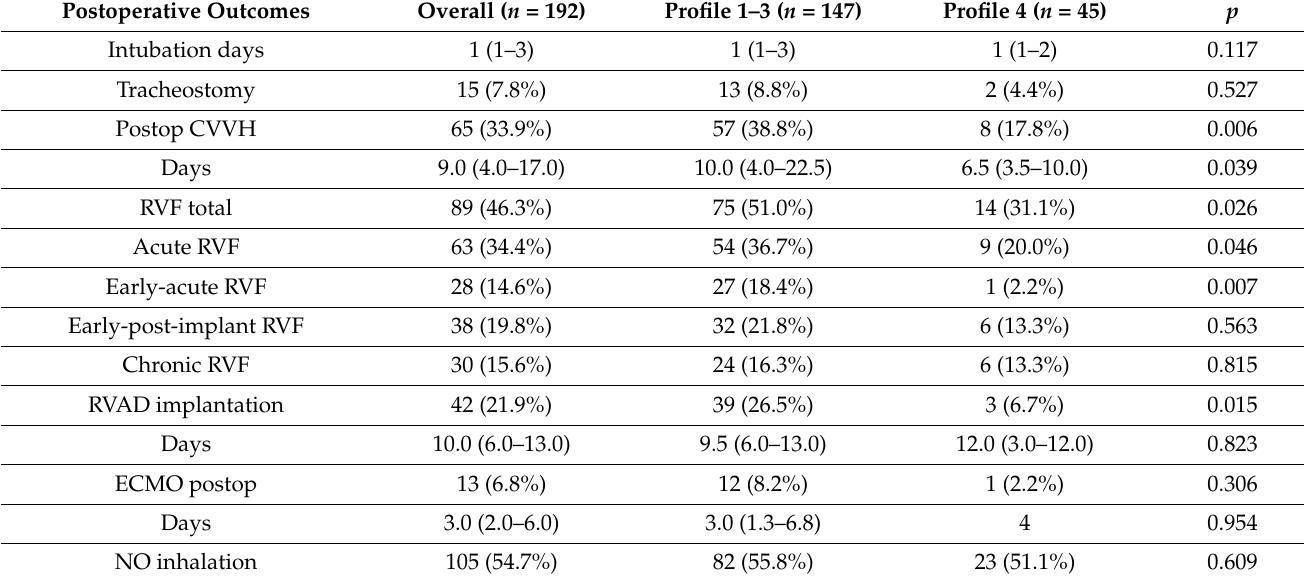
Table 3. Postoperative outcomes and major adverse events of overall ( n = 192), INTERMACS Profile1–3 ( n = 147) and Profile 4 ( n = 45)